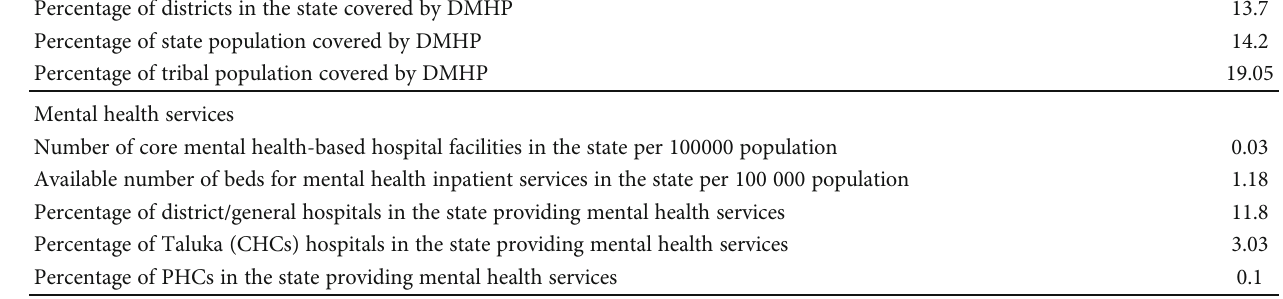
Table 1: Coverage of District Mental Health Program and mental health services in Madhya Pradesh (2015-16). Coverage of DMHP (District Mental Health Program) Number of districts where DMHP is started during the 12th plan period (2012 to 2017) in the state.